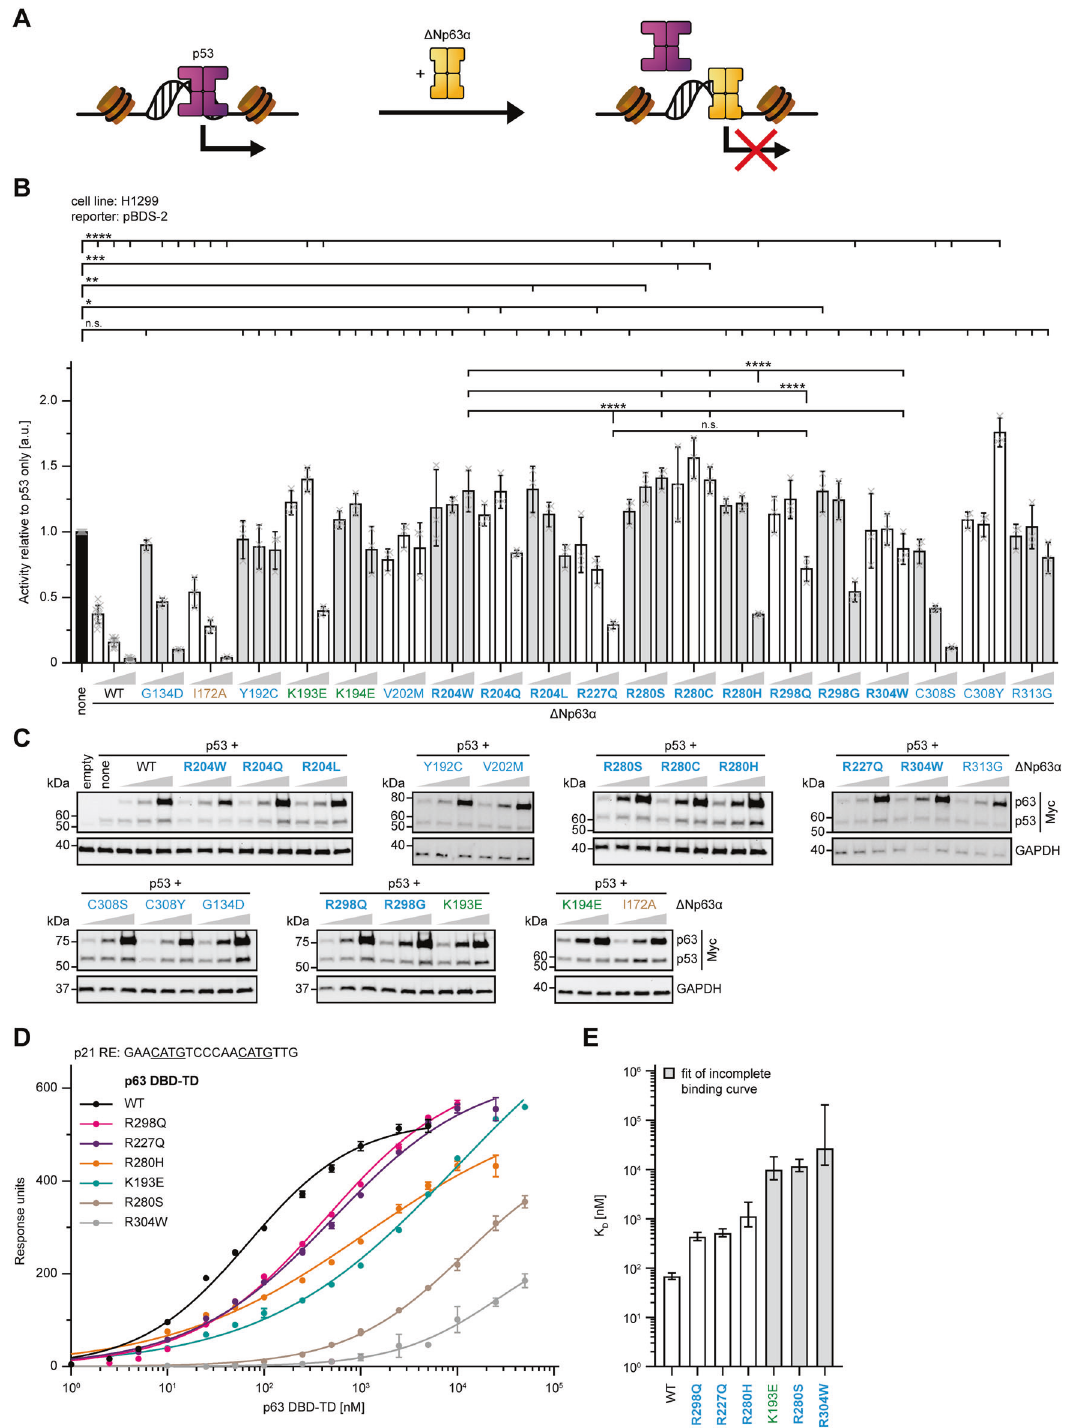
binding interface. Other structural mutations locally distort the DNA binding interface without affecting the zinc fi nger (4) while mutations in the core of the DBD cause global unfolding of the metastable DBD and thereby impair DNA binding (5). These core mutations are also referred to as temperature sensitive muta- tions because DNA binding is retained at low temperatures, which do not induce global unfolding. In contrast to p53 and p63, to date neither cancer nor other human diseases have been linked to mutations in the p73 gene [3, 18,